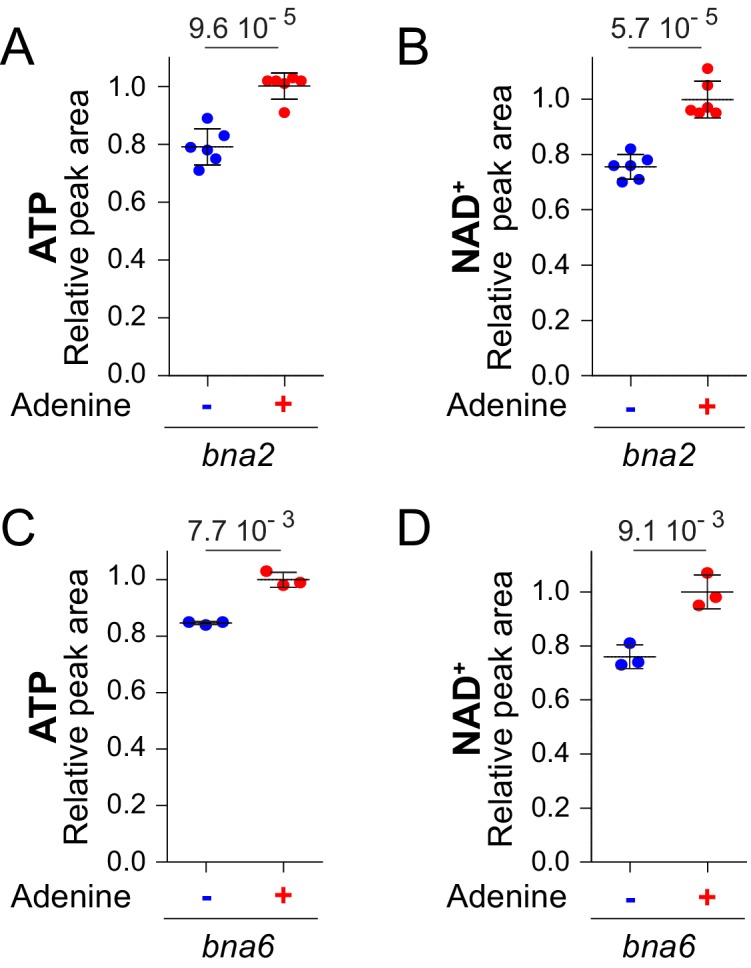
NAD+variations in response to external adenine availability do not require a functional pyridine de novo pathway.ATP (A–C) and NAD+ (B–D) levels were determined from bna2 (Y10838) and bna6 (Y5891) knock-out mutants exponentially grown for 24 hr in SDcasaWU supplemented (red dots) or not (blue dots) with adenine. Quantifications were determined from independent metabolite extractions (A-B: N = 6; C-D: N = 3) and standard deviation is presented. Metabolite amount measured in cells grown in the presence of adenine (red dots) was set at 1. A Welch’s t-test was used to determine the indicated p-values.10.7554/eLife.43808.041Figure 6—figure supplement 1—source data 1.Metabolic analyses for bna2 and bna6 mutant strains grown in ±adenine.